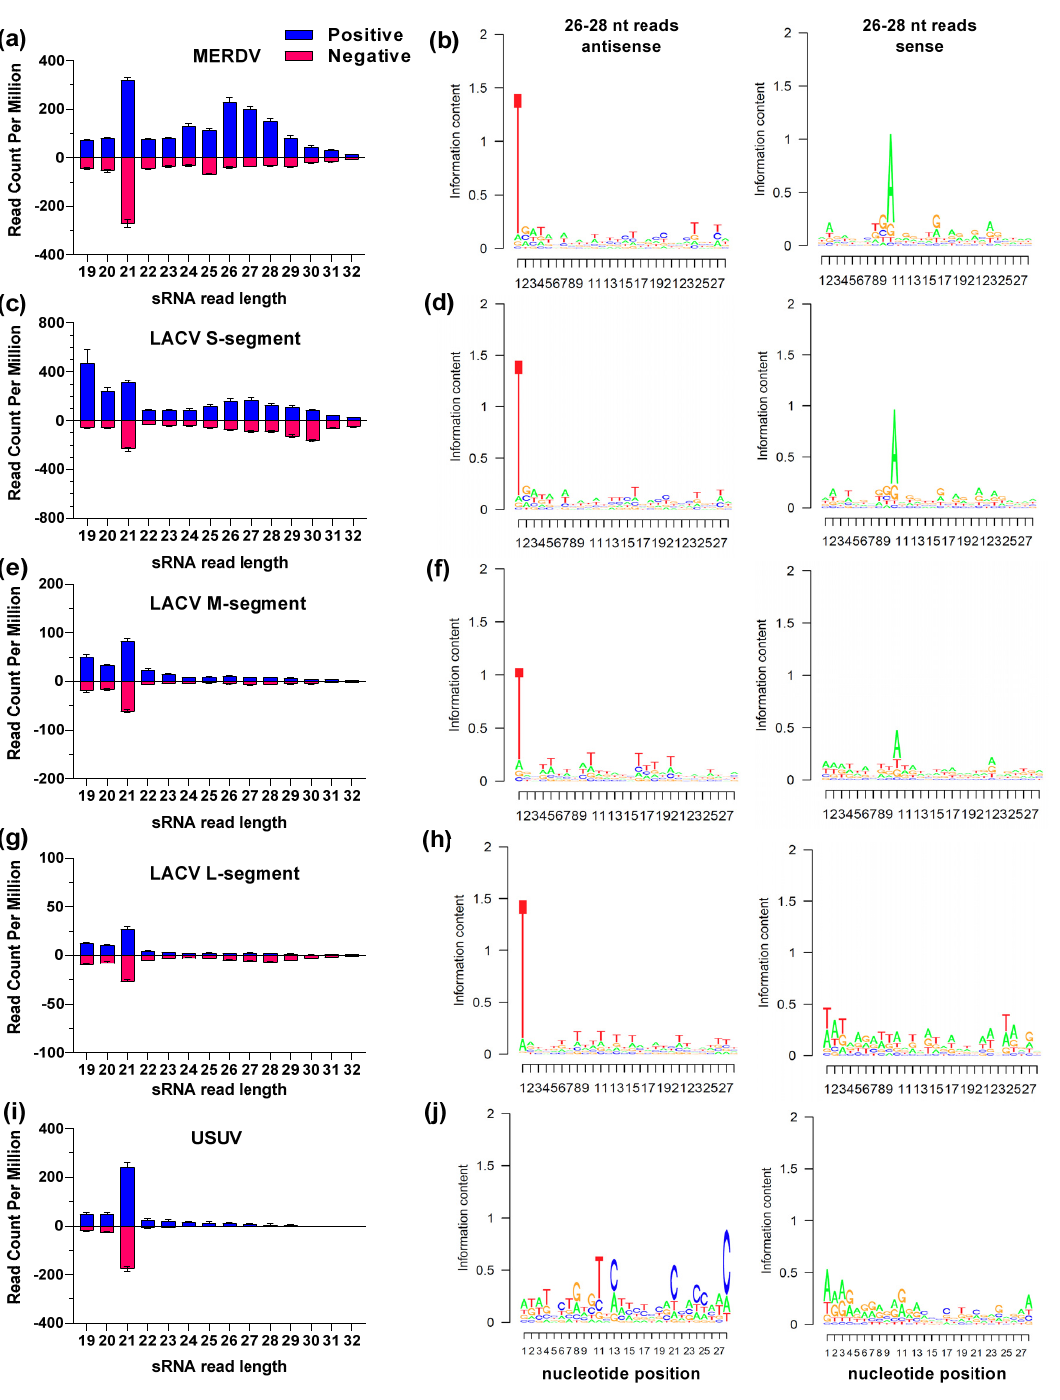
Figure 5. Virus ‐ derived sRNA reads in Cx. quinquefasciatus cells. sRNA libraries were sequenced from non ‐ treated Hsu cells ( a , b ) or 2 dpi with LACV ( c – h ), or USUV ( i , j ). 19–32 nt reads were aligned to the respective virus genomes and histograms are shown for MERDV ( a ), LACV S segment ( c ), LACV M segment ( e ), LACV L segment ( g ), and USUV ( i ). The sRNA read counts per million total sRNA reads are shown as the mean of 3 biological replicates. Nucleotide biases of 26–28 nt sRNA reads derived from the antisense (left) and sense (right) strands of MERDV ( b ), LACV S segment ( d ), LACV M segment ( f ), LACV L segment ( h ), and USUV ( j ) are shown.